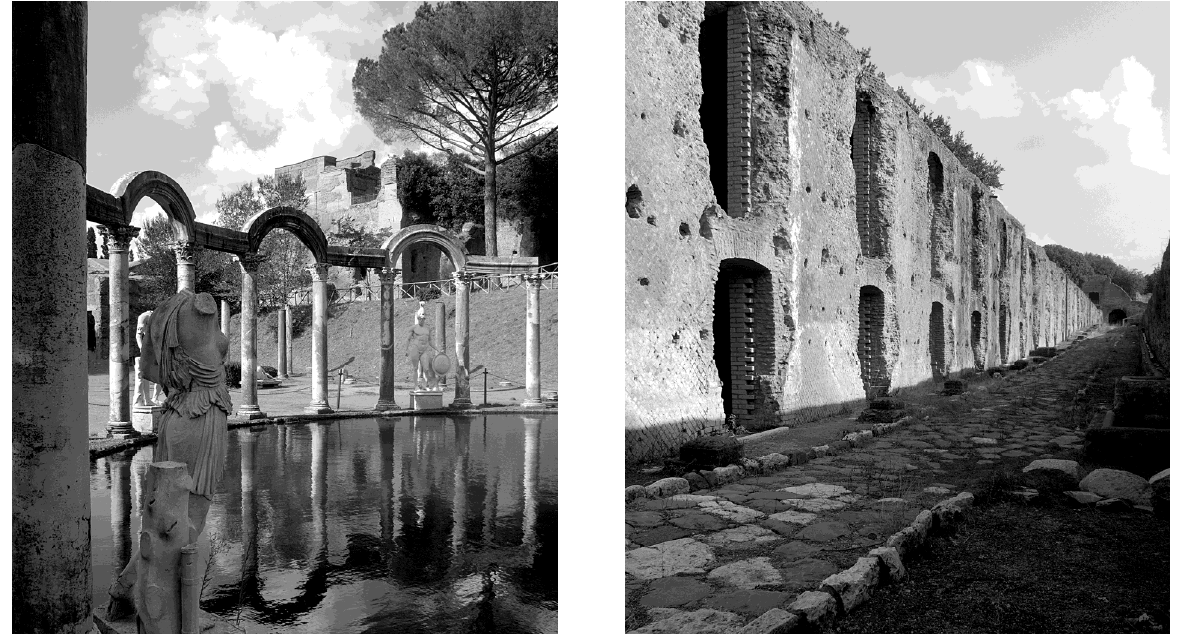
Figure 1: Detail of the Canopo canal (the so called tricline of water) [foto di G. Foti]. Figure 2: The carriageway C of the servants and the Cento Camerelle, habitation of the servants [foto di G.